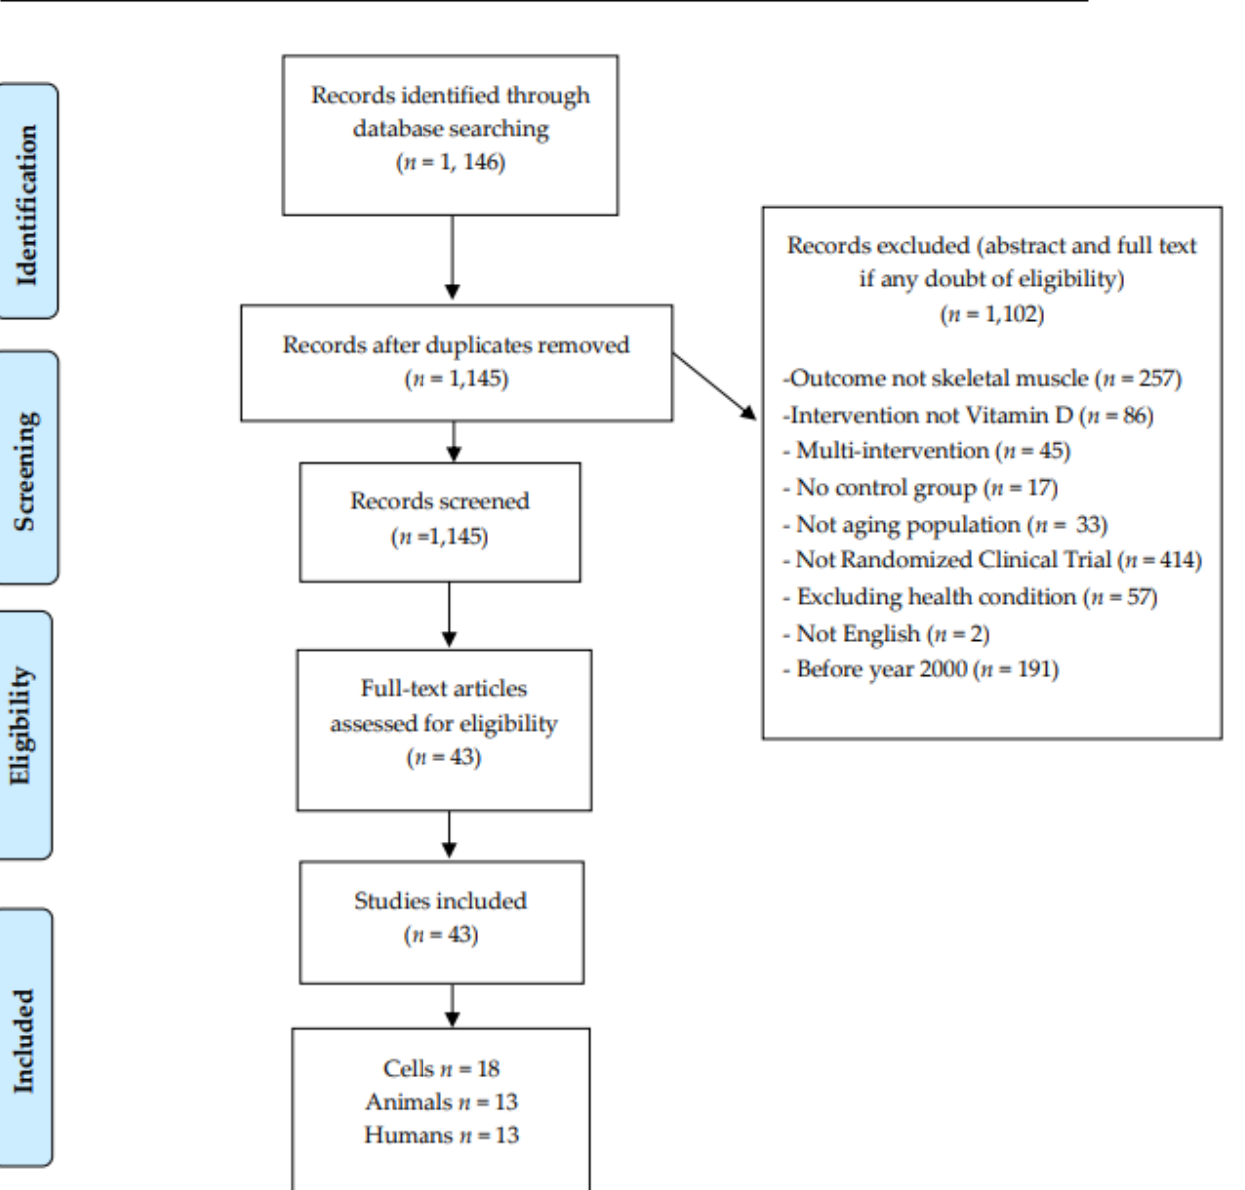
Figure 1. PRISMA flow diagram of research stages.